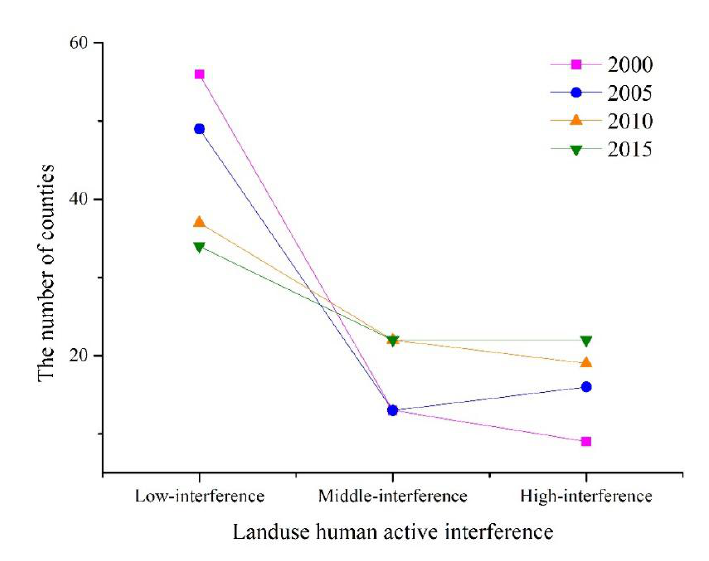
Figure 6. The number of counties with different LHAI.